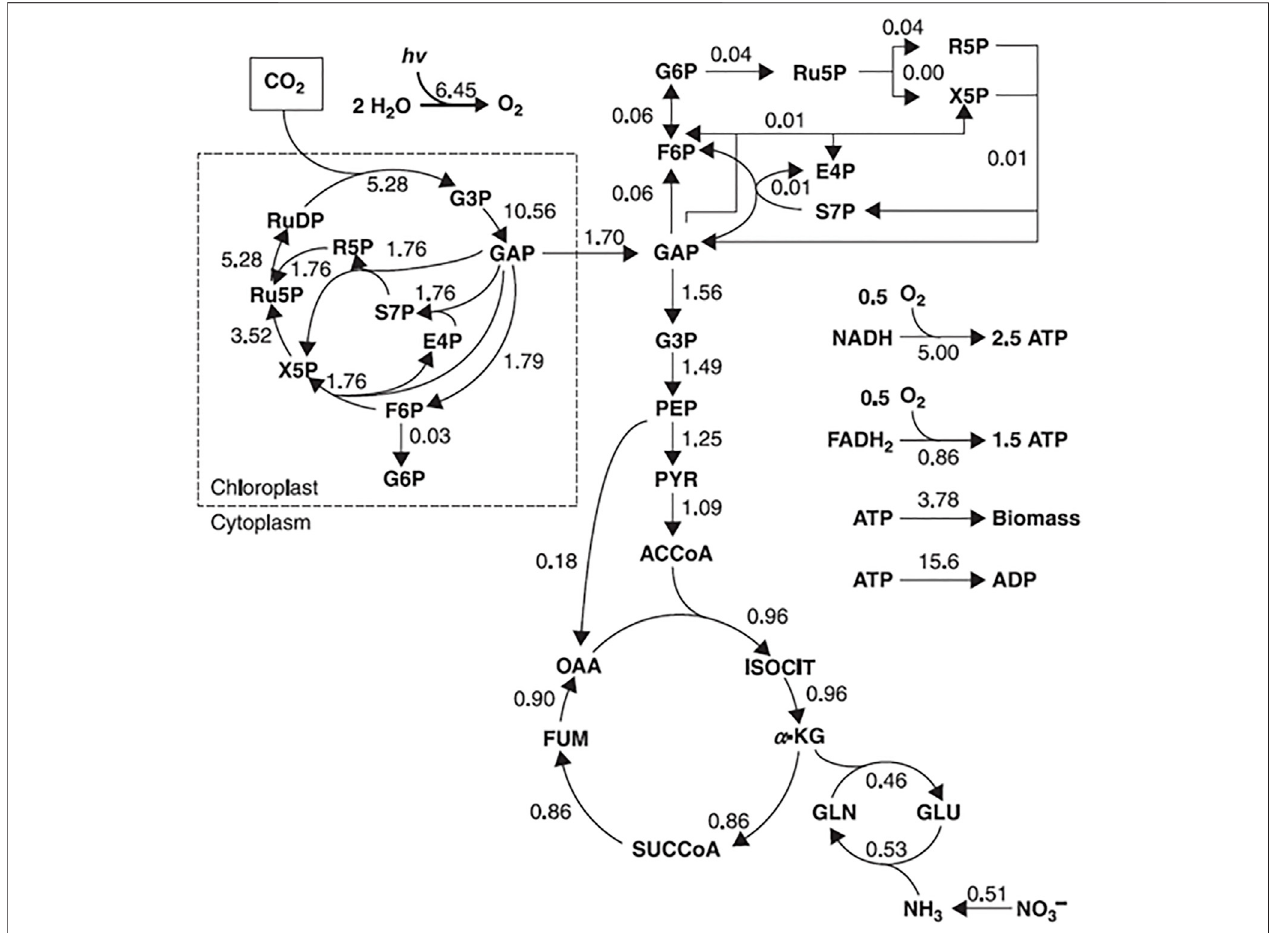
FIGURE 4 | Example of a fl ux map, representing a metabolic fl ux distribution of Chlorella cells in autotrophic cultures. The fl ux values are expressed in mmol/g/h. Adapted with permission from (Shimizu and Shimizu, 2013).